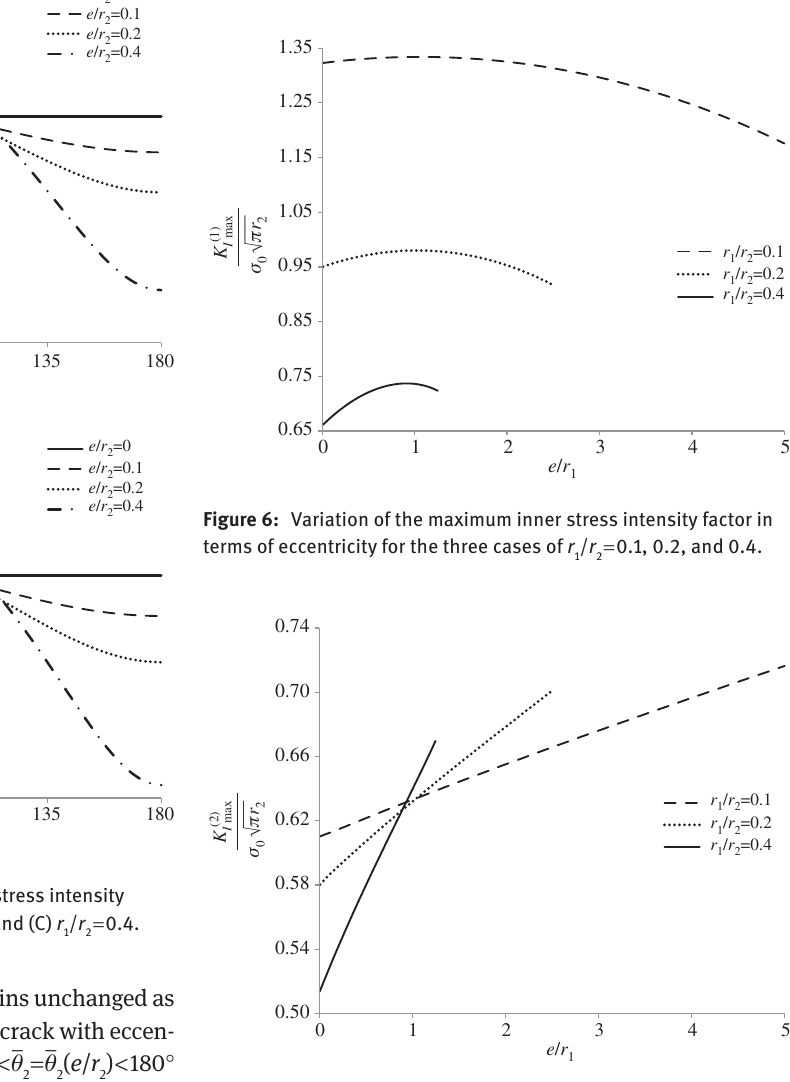
Figure 7: Variation of the maximum outer stress intensity factor in terms of eccentricity for the three cases of r